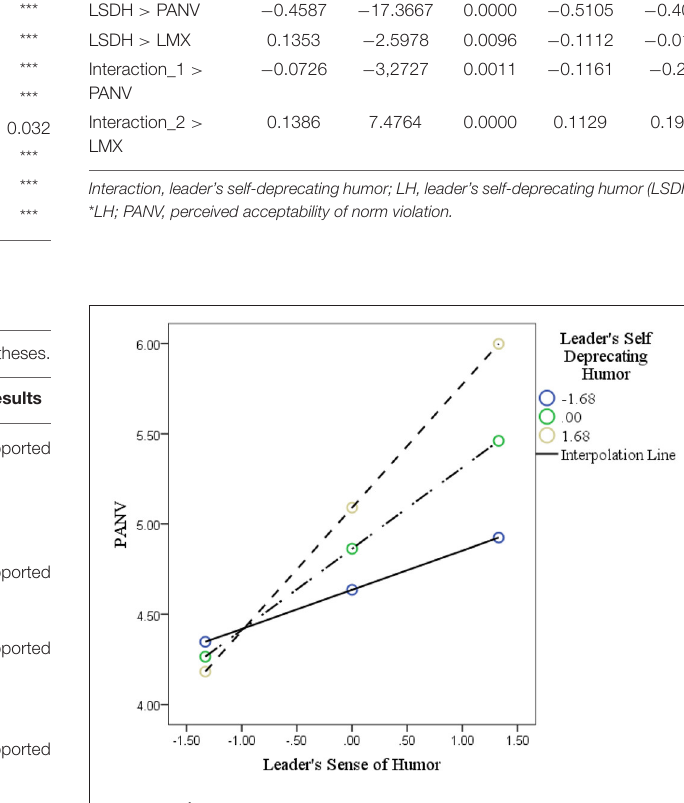
FIGURE 4 | The interaction of leader’s self-deprecating humor and leader’s humor on